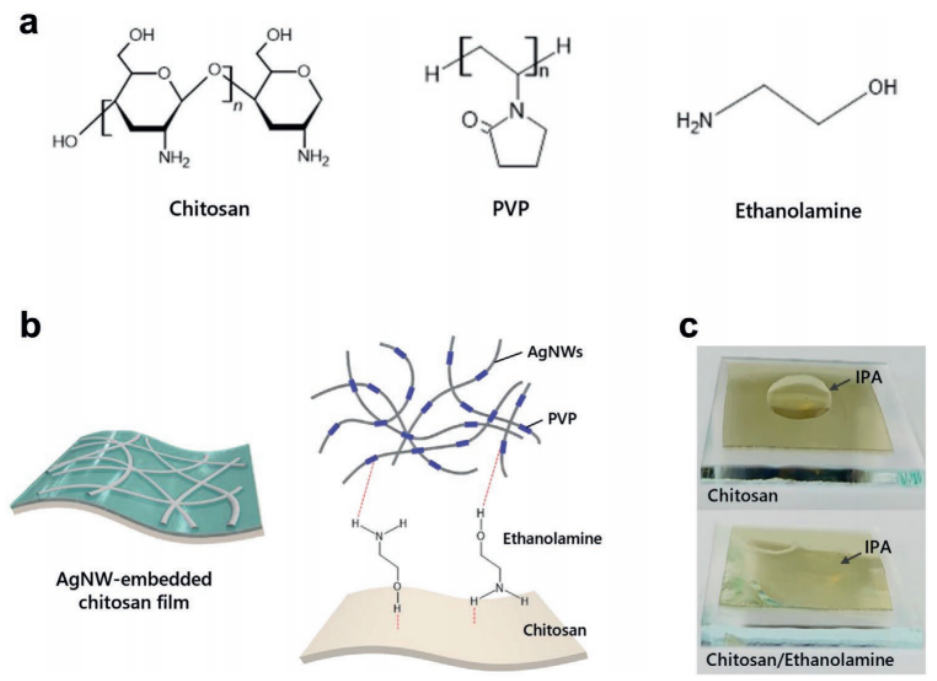
Figure 10. ( a ) Chemical structures of chitosan, PVP and ethanolamine (EA). ( b ) Schematic of the AgNW-embedded chitosan film and interface functionalization mechanism between the AgNWs and the chitosan substrate. ( c ) IPA droplet images of the untreated chitosan and the EA-treated chitosan films. Reprinted with permission from [110]. Copyright 2021 John Wiley and